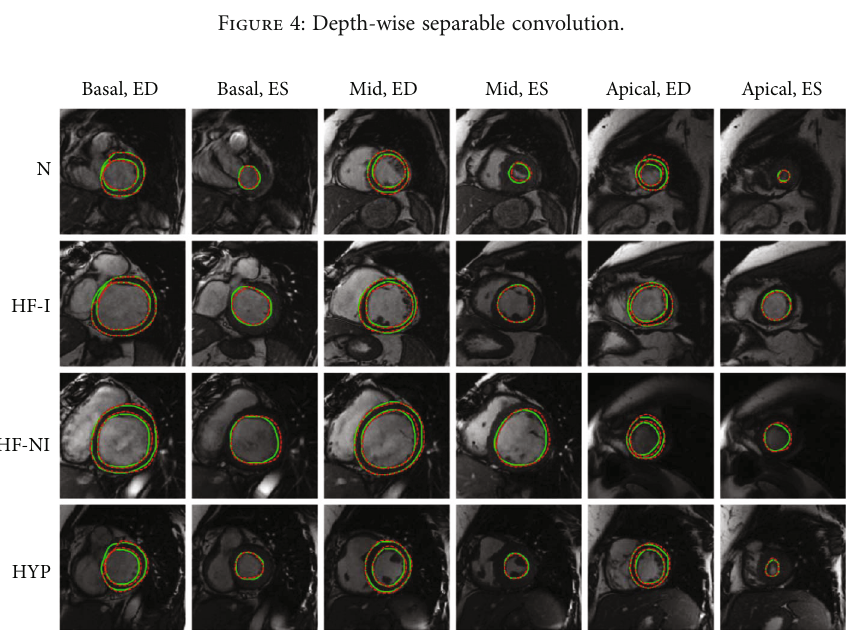
Figure 5: Automatic segmentation (solid green line) and ground truth (dotted red line) in the basial slice, midslice, and apical slice for four types of patients, labeled with Basal (basal slice), Mid (midslice), Apical (apical slice), ED (end-diastole), ES (end-systole), N (normal), HF-I (heart failure with ischemia), HF-NI (heart failure without ischemia), and HYP